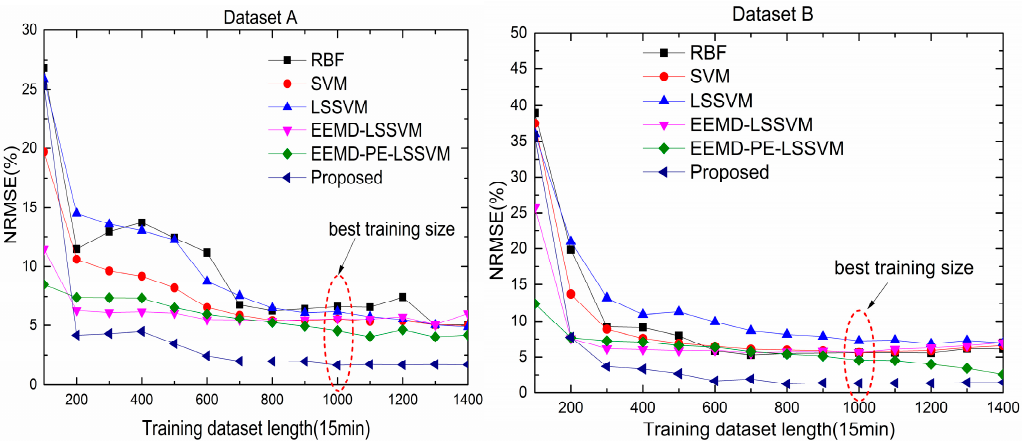
Figure 8. The NRMSE of 1-step-ahead forecasting by different models with two training datasets.